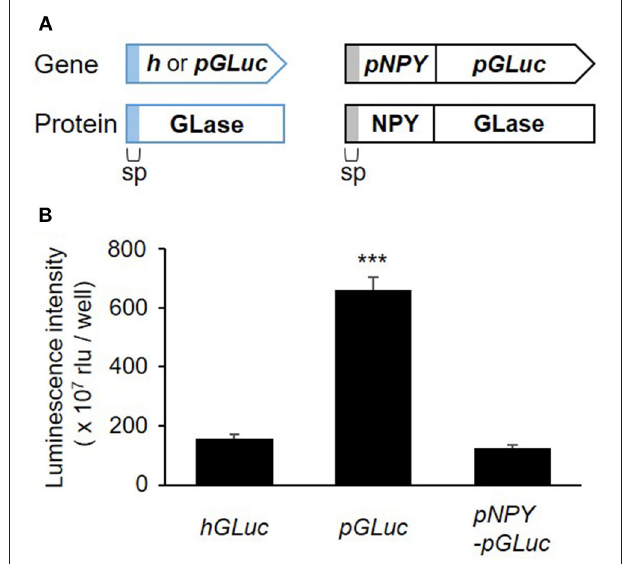
FIGURE 1 | Secretory expression of GLase and NPY-GLase in RBL-2H3 cells. (A) Schematic representation of the genes for GLase and NPY-GLase reporter proteins. sp, signal peptide sequence for secretion. (B) Luminescence activities of RBL-2H3 cells in the culture medium after 24h and transfection with the expression vectors pcDNA3-hGLuc ( hGLuc ), pcDNA3-pGLuc ( pGLuc ), and pcDNA3-pNPY-pGLuc ( pNPY - pGLuc ). Data represent the means ± SD ( n = 4, *** p < 0.001 vs hGLuc ).